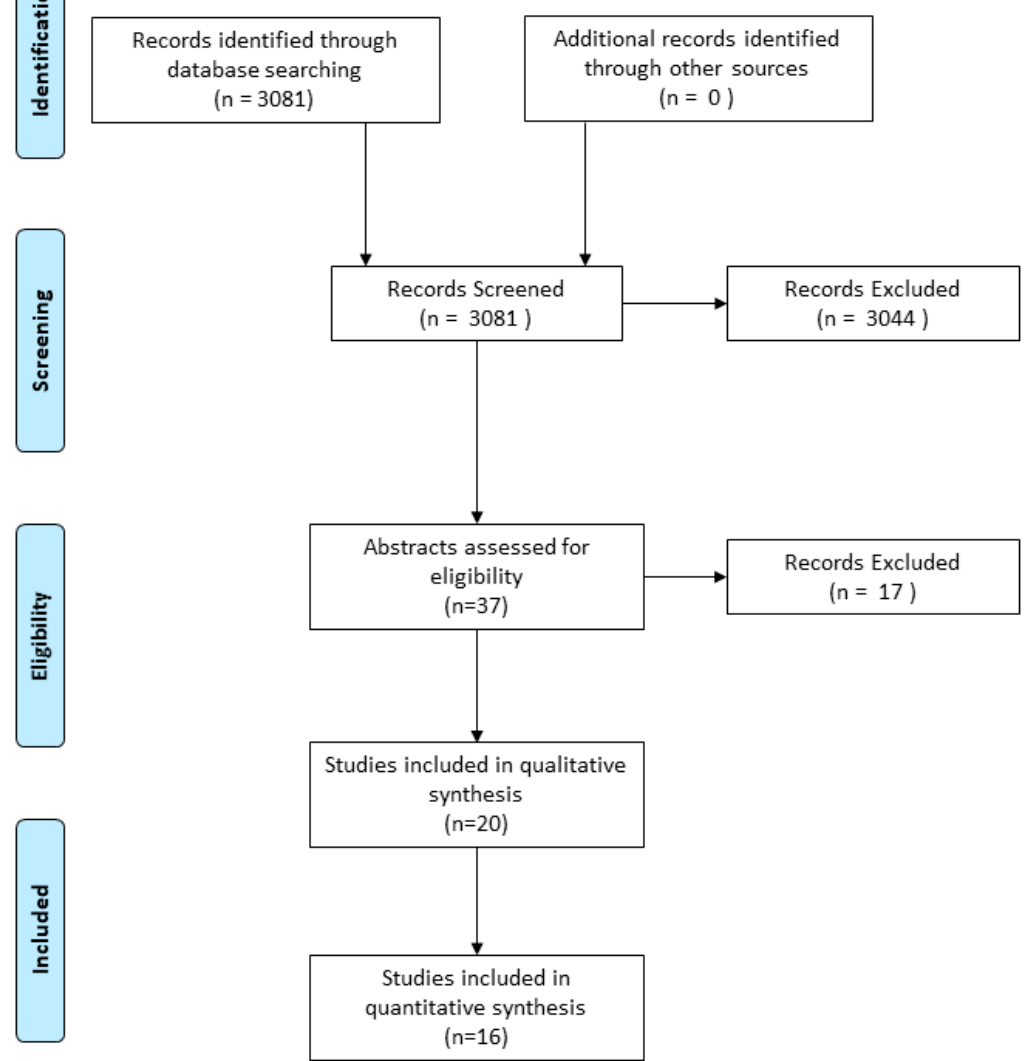
Figure 8. PRISMA diagram showing how records were screened and selected to be used for the systematic review.